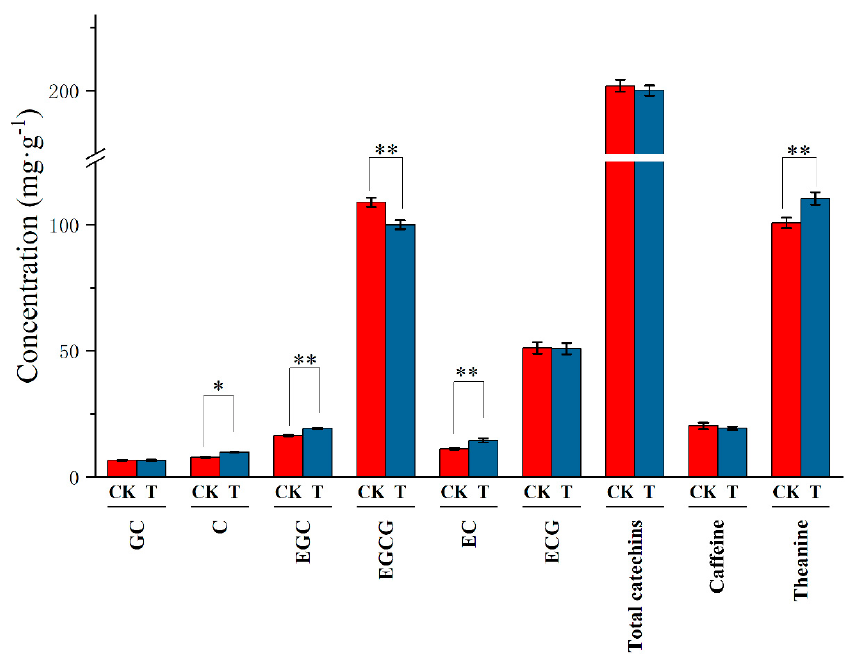
Figure 3. Change in quality-related components in tea leaves under tea plant–soybean intercropping. CK: tea plant in monoculture. T: tea plant in tea plant/soybean intercropping system. All data are shown as the mean ± SD ( n = 3). Asterisks represent significant differences (Tukey’s HSD test, * represents p < 0.05, ** represents p <